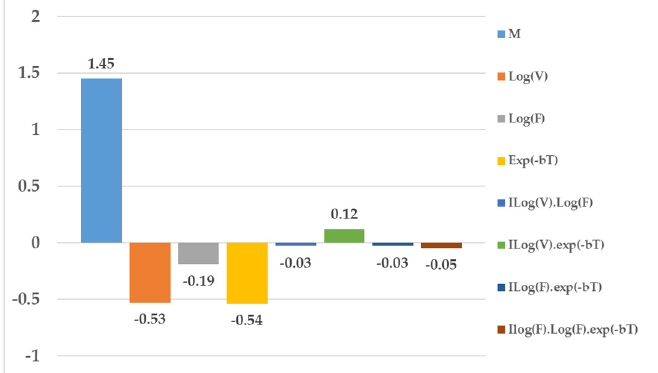
Figure 5. Influence factors of the lifetime using DOE.